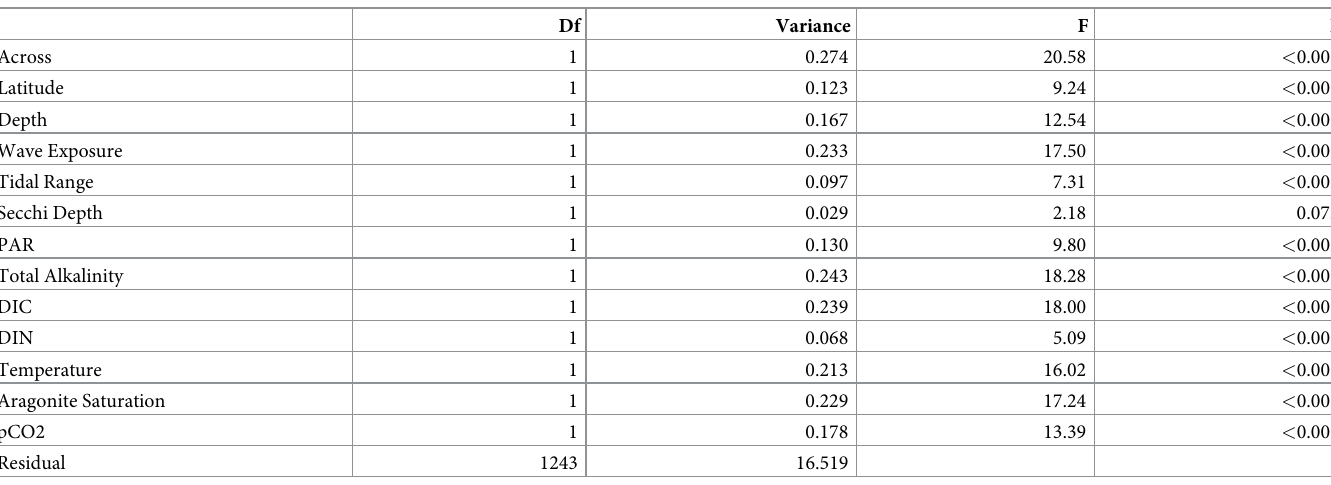
Table 1. Significance of the predictors for the community